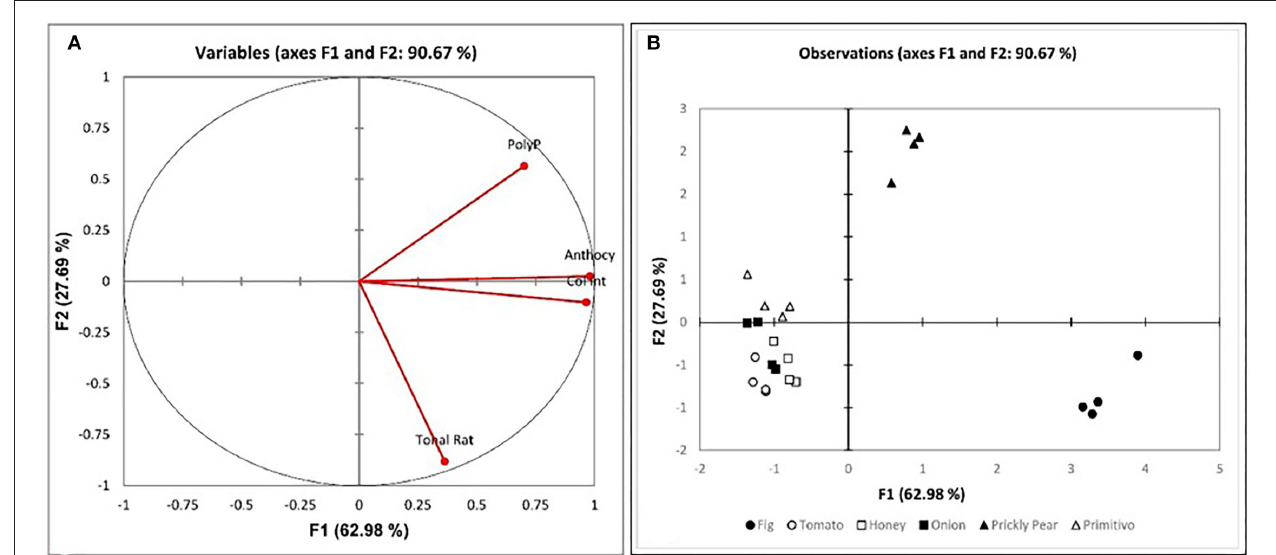
FIGURE 3 | PCA analysis of the physicochemical parameters by matrix; (A) Variables plot with percentages of data variability for different substrate ferments (the accelerated wood-aged vinegar samples) of 90.67% is accounted for; (B) Score plot of the physicochemical variables and the chemical components of the various substrates at the end of the